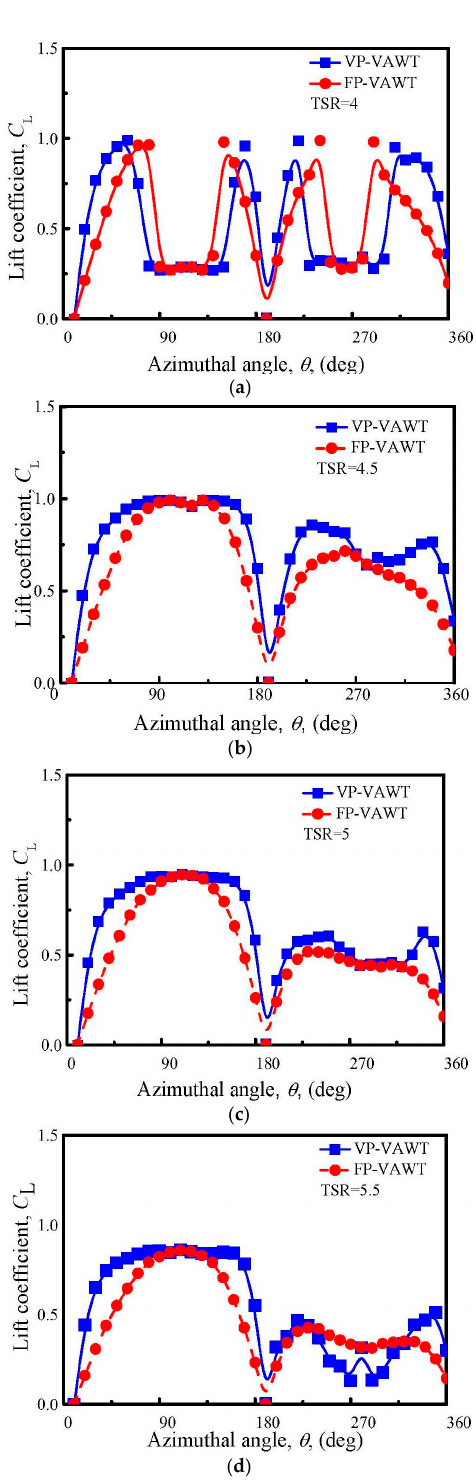
Figure 10. Lift coefficient as a function of azimuthal angle in VP-VAWTs and FP-VAWTs. ( a ) TSR = 4; ( b ) TSR = 4.5; ( c ) TSR = 5; ( d ) TSR = 5.5.